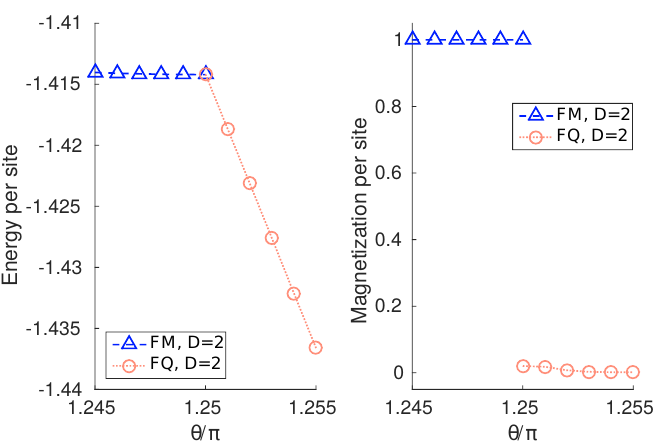
Figure 13: Energy per site (left) and magnetization per site (right) for the ferromagnetic (FM) and ferroquadrupolar (FQ) states as a function of θ . No extrapolation is needed because both phases are represented by product states. The kink in energy and jump in magnetization show that this transition is first